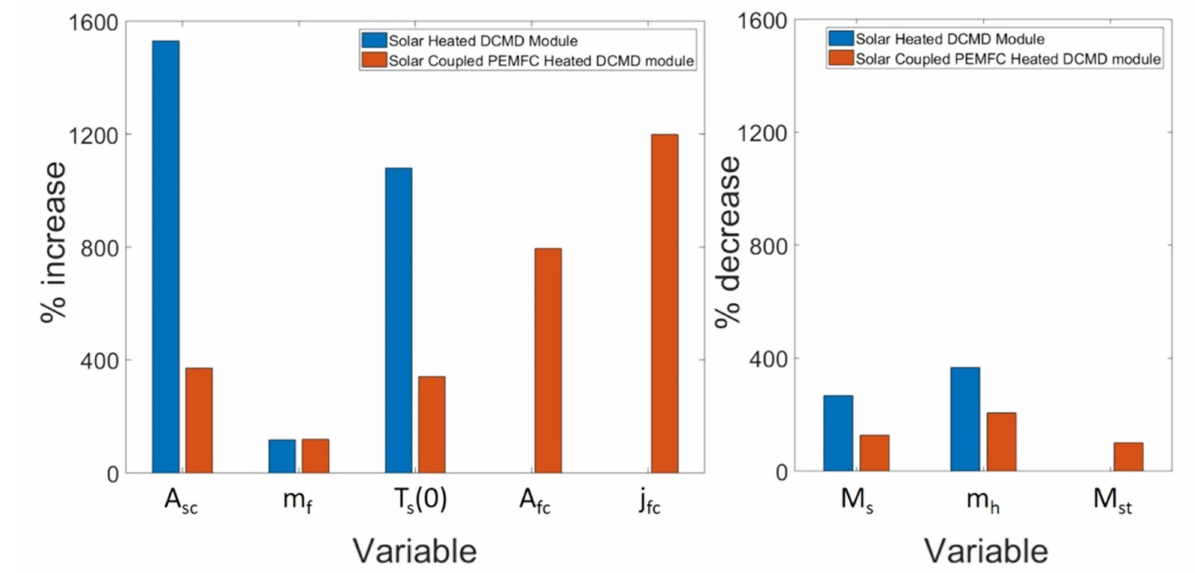
Figure 8. The changes of each parameter for both systems in the sensitivity analysis.